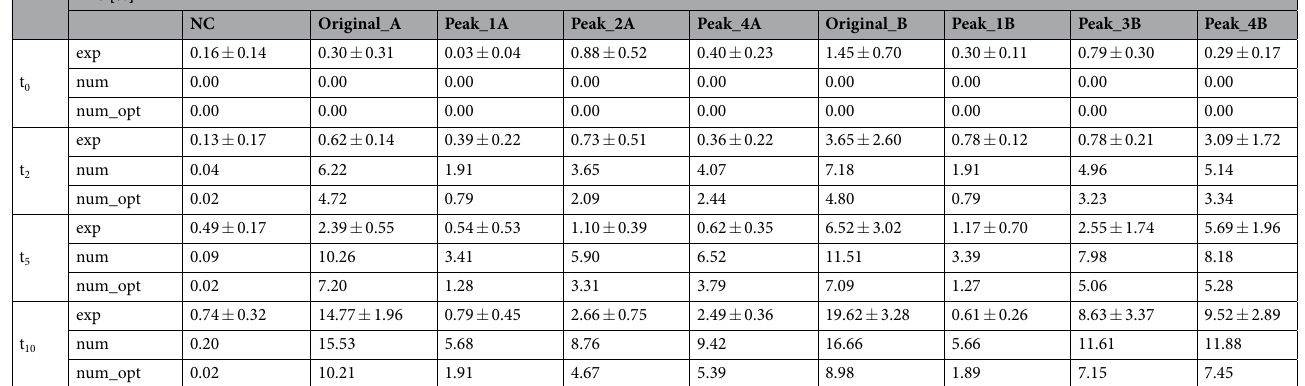
Table 4. Experimental and numerical values of PAS: data are reported for the whole data set of test curves for each of the defined measurement time points: t 0 : 0 min, t 2 : 2 min, t 5 : 5 min, t 10 : 10 min; exp: experimental values: num: numerical predictions according to 23 ; num_opt: numerical predictions obtained with the optimized set of model parameters defined in this study.